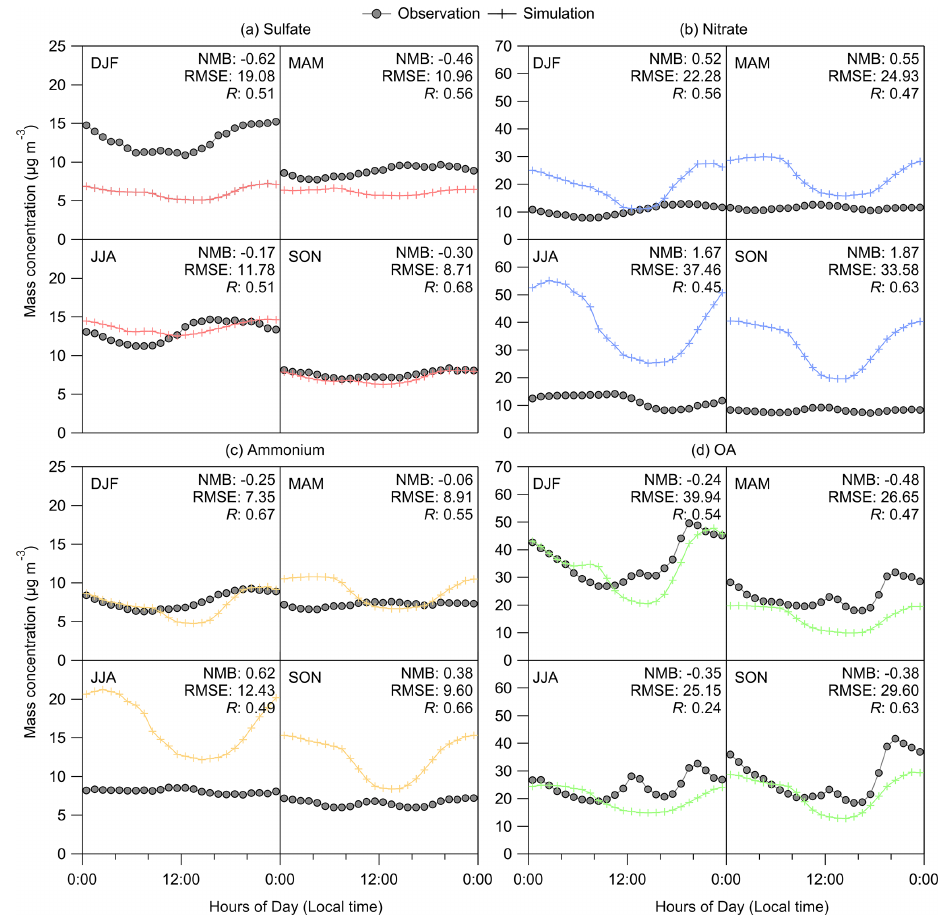
Figure 2. Diurnal profiles of the simulated and observed hourly mean concentrations of (a) sulfate, (b) nitrate, (c) ammonium, and (d) OA at the IAP site in Beijing from July 2011 to May 2013. The observed concentrations were divided by a submicron-to-fine ratio of